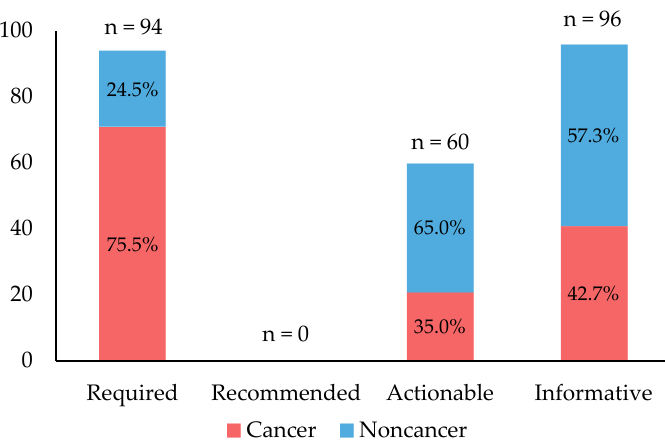
Figure 4. PharmGKB PGx Levels of biomarker–drug pairs for cancer and non-cancer therapies.